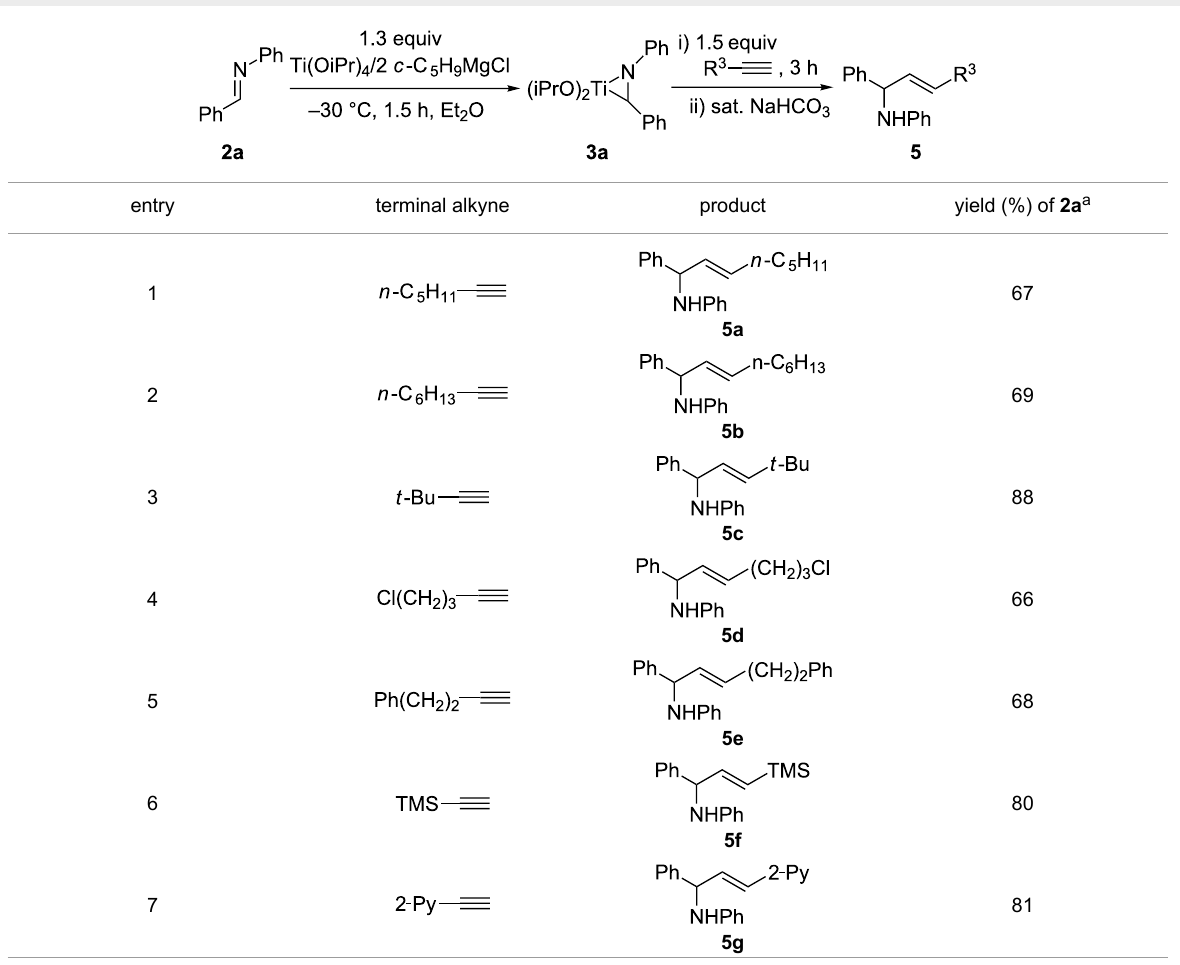
Table 1: Synthesis of various allylic amines by titanium-mediated coupling reactions of imine 2a with different terminal